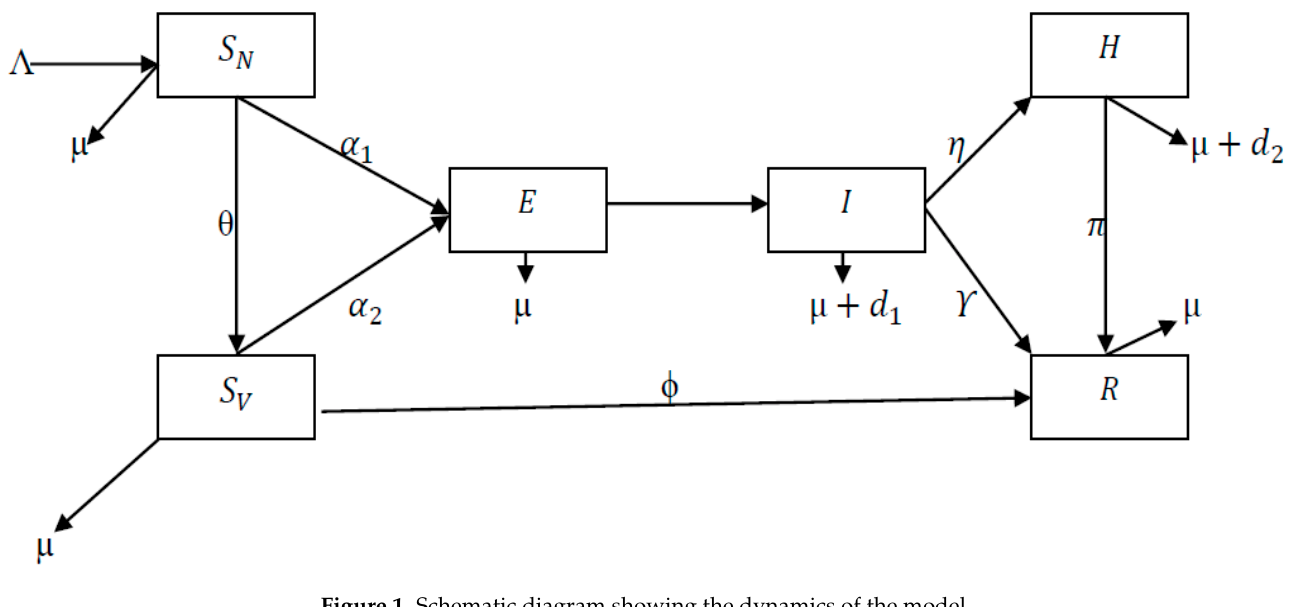
Figure 1. Schematic diagram showing the dynamics of the model.